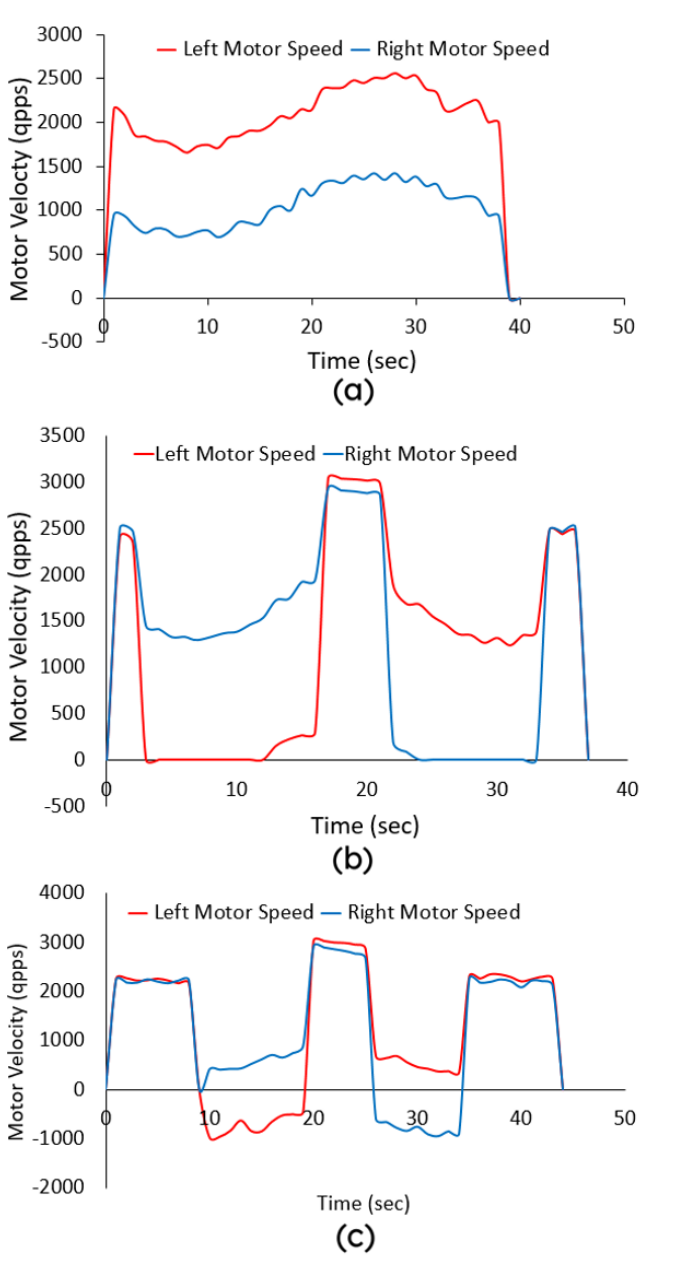
Figure 22. Locomotion of the Mantis-mini platform along ( a ) circular, ( b ) s-shaped ( c ) z-shaped